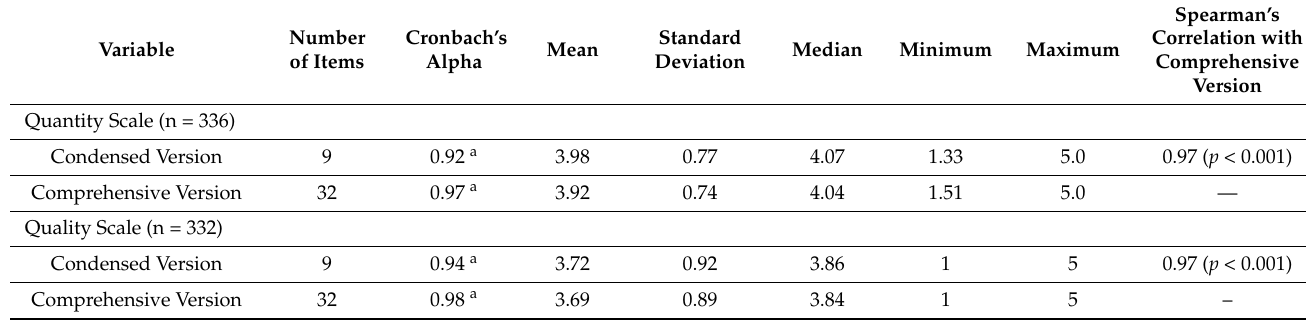
Table 2. Condensed REST and Comprehensive REST Comparison.